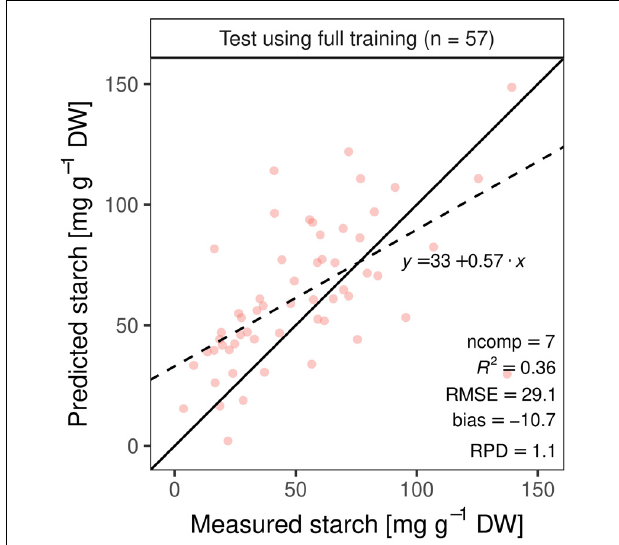
FIGURE 8 | Best performing model from the training set was used to predict leaf starch content in an independent test set ( n =